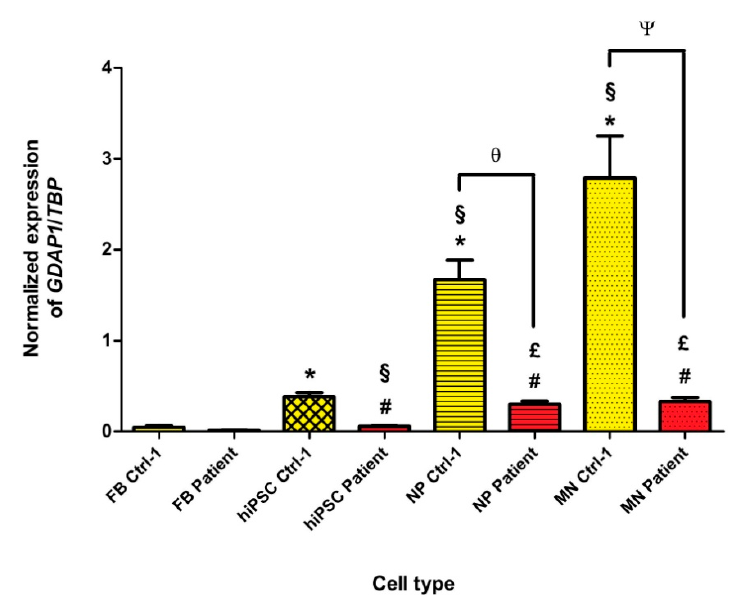
Figure 3. Normalized GDAP1 expression in fibroblasts (FBs), human induced-pluripotent stem cells (hiPSCs), neural progenitors (NPs), and motor neurons (MNs), from Ctrl-1 subject (yellow plots) and CMT patient (red plots). TBP was chosen as reference gene. * p < 0.05 vs. FB Ctrl-1; § p < 0.05 vs. hiPSC Ctrl-1; # p < 0.05 vs. FB patient; £ p < 0.05 vs. hiPSC patient; θ p < 0.05 vs. NP Ctrl-1; Ψ p < 0.05